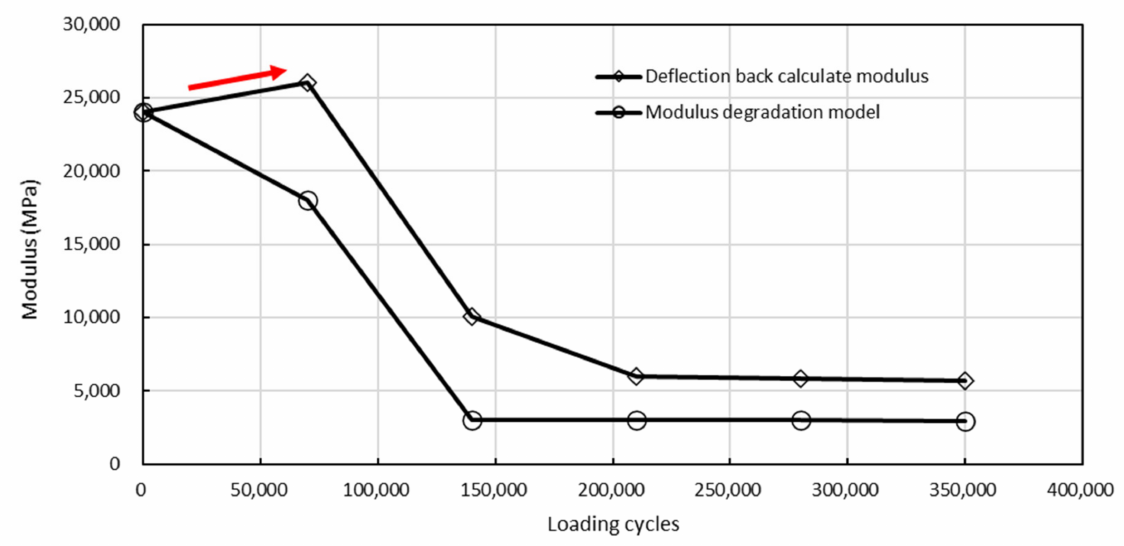
Figure 16. The modulus of deflection back calculation and degradation model in Structure